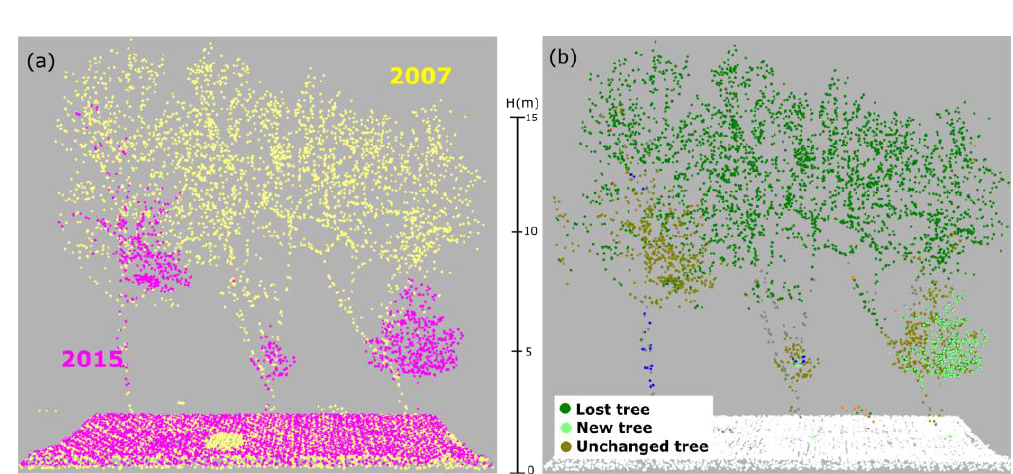
Figure 10. New trees planted at the same location as old lost trees: ( a ) point clouds of 2007 and 2015; and ( b ) change detection and classification results.